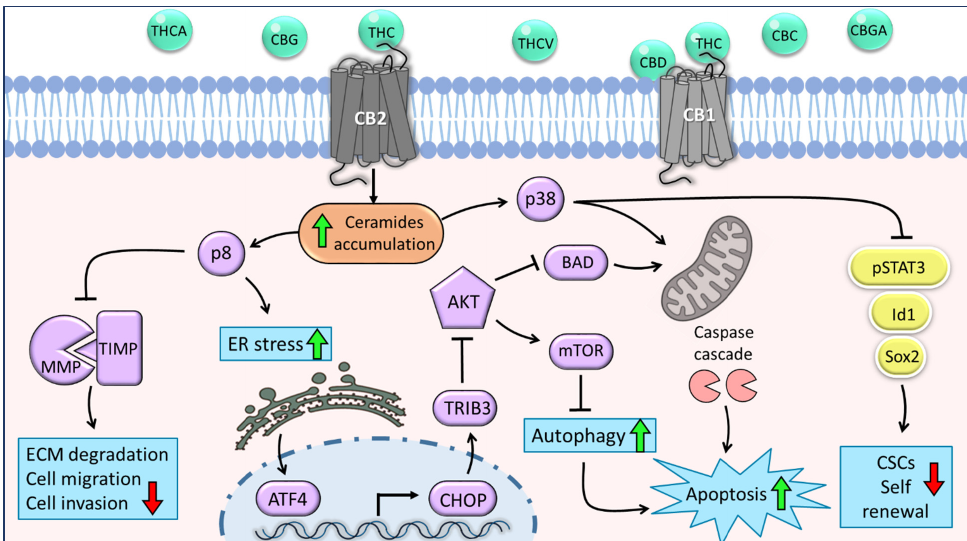
Figure 1. The main molecular mechanisms underlying the anti-tumor effects of C. sativa phytocannabinoids on glioma cells and glioblastoma stem cells. Phytocannabinoids inhibit cell viability and motility through various cannabinoid receptor (CB)-mediated mechanisms. THC acts as an agonist of both CB1 and CB2 receptors; CBD may act as a CB1 antagonist. The activation of CB1 or CB2 stimulates the synthesis and accumulation of ceramides (orange shape) and, as a result, triggers the induction of p8. This leads to the inhibition of cell migration and invasion through the downregulation of MMPs. Furthermore, p8 promotes the upregulation of ER-stress-related genes ATF-4 , CHOP , and TRIB-3 , followed by inhibition of the Akt-mTORC1 axis and initiation of autophagy, which is upstream of apoptosis. In addition, inhibition of Akt leads to the overexpression of BAD and consequently induces apoptosis via the intrinsic mitochondrial pathway. Another signaling pathway activated by ceramides is p38-MAPK, which involves both apoptosis activation and inhibition of CSC self-renewal through the downregulation of stemness regulators, such as p-STAT3, Id1, and Sox2 (yellow shapes). Green arrows represent upregulation and red arrows represent downregulation of biological processes. Purple shapes represent genes or proteins, and blue shapes represent biological processes.